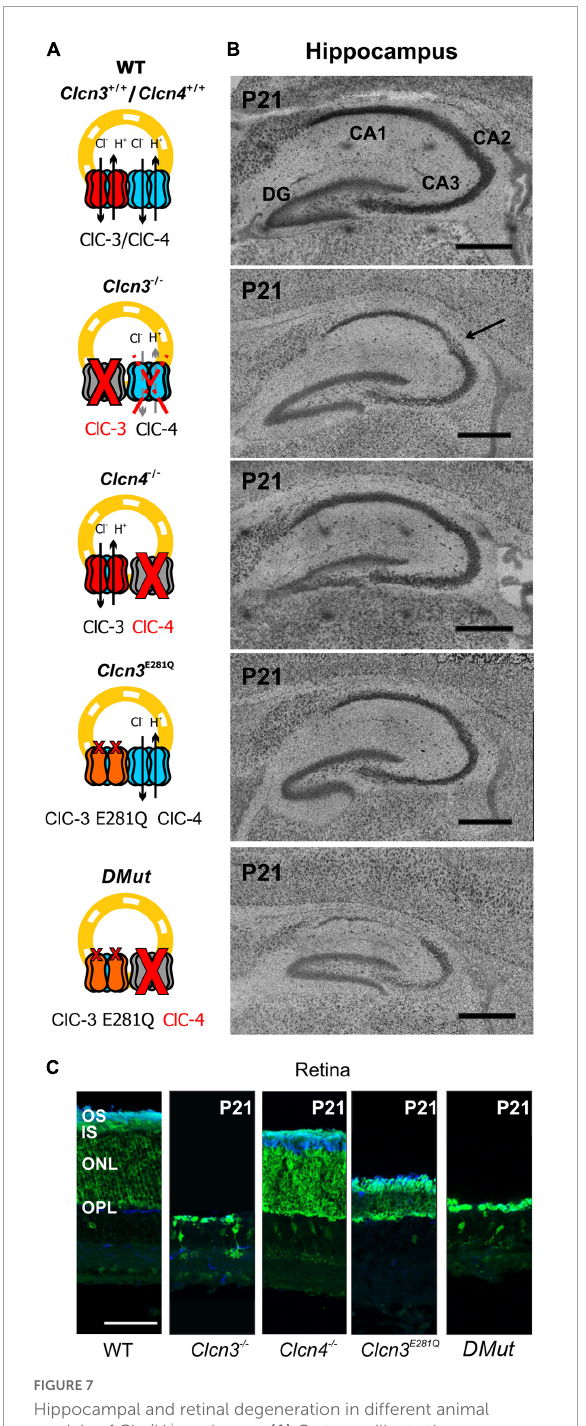
FIGURE7 Hippocampal and retinal degeneration in different animal models of Cl − /H + exchange. (A) Cartoons illustrating heterodimerization between ClC-3 and ClC-4 and the contribution of Cl − /H + transport function in endosomes for each genotype and (B) representative confocal images of Nissl-stained sagittal (100 µ m) section indicating hippocampal formation from 21-day-old WT, Clcn3 − / − , Clcn3 E 281 Q / E 281 Q , Clcn4 − / − , and Clcn3 E 281 Q / E 281 Q /Clcn4 − / − ( DMut ) mice. The arrow indicates neurodegeneration in the CA2 region of the